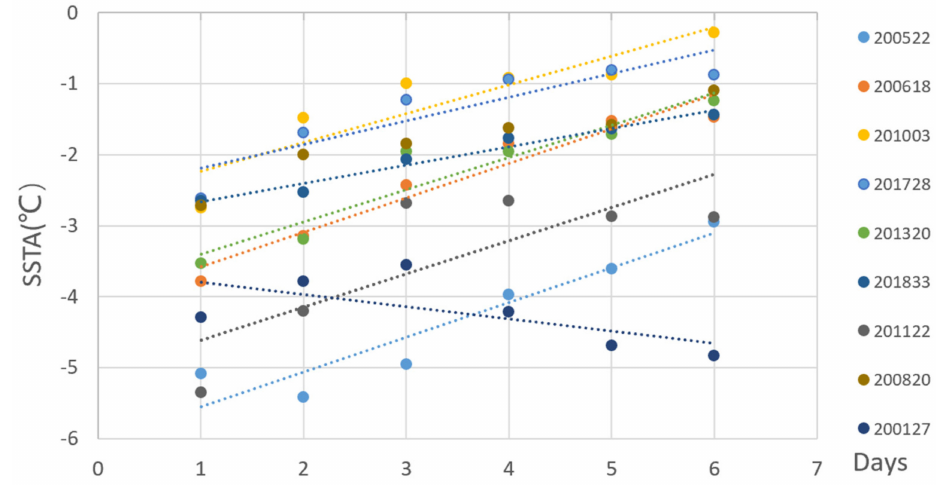
Figure 5. Rising trend line of SST after westward typhoon: The legend part is the typhoon number. Further analysis of the slope of the SST recovery trend line reveal that the SST recovery slope was between 0.1–0.5 for the 20 westward typhoon that caused obvious cooling